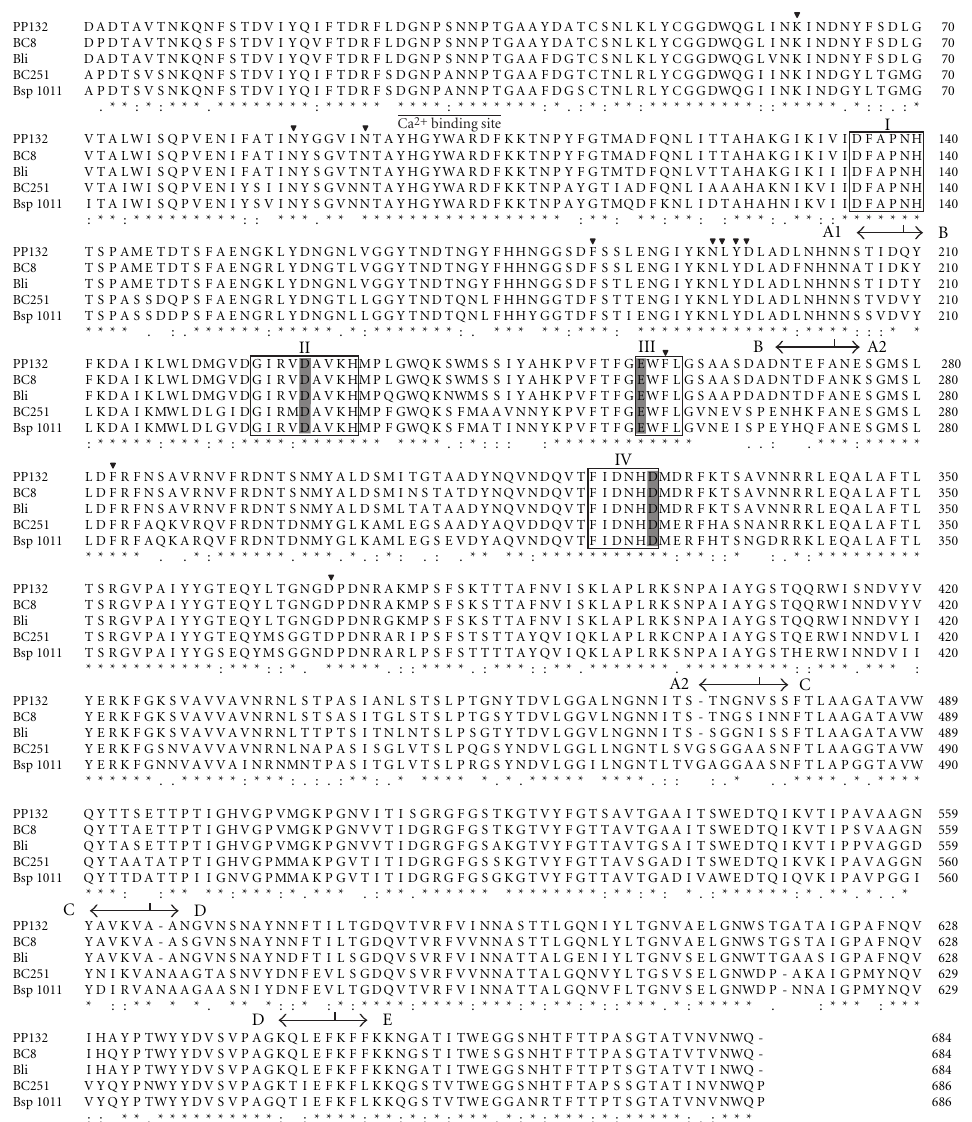
Figure 2: Comparison of the deduced amino acid sequence of US132 CGTase with those of related CGTases. The five domains found in CGTase proteins are indicated by letters A to E under the sequences. The four highly conserved regions are boxed and the catalytic residues are shaded. Arrows indicate the main amino acid residues of cyclization activity Lys47, Tyr89, Asn94, Phe183, Asn193, Leu194, Tyr195, Asp196, Phe259, Phe283, and Asp371. The numbering starts after the respective signal sequence, with identity ( ∗ ), strongly similar (:), and weakly similar ( · ). PP132: CGTase of Paenibacillus pabuli US132 strain; BC8: CGTase of Bacillus circulans strain no. 8; Bli: CGTase of Bacillus licheniformis ; BC251: CGTase of Bacillus circulans strain 251; Bsp1011: CGTase of Bacillus